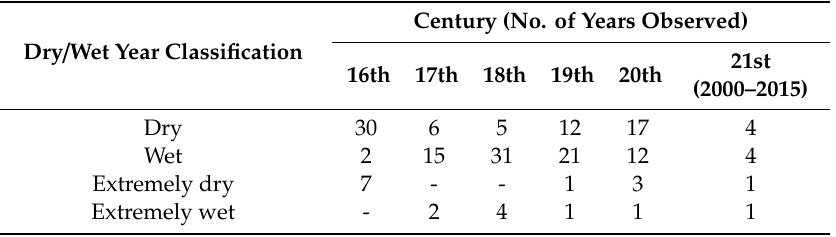
Table 4. Frequency of occurrence of dry / wet and extreme dry / wet